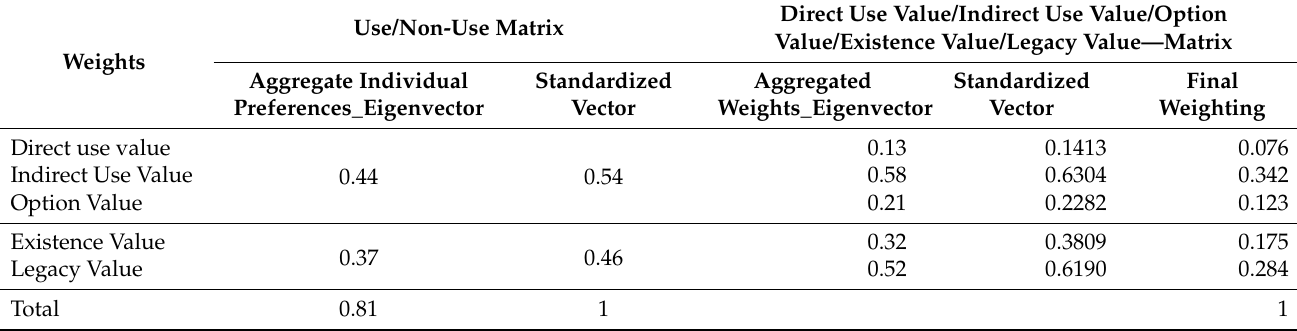
Table 4. Final weightings of the components of the Total Economic Value.